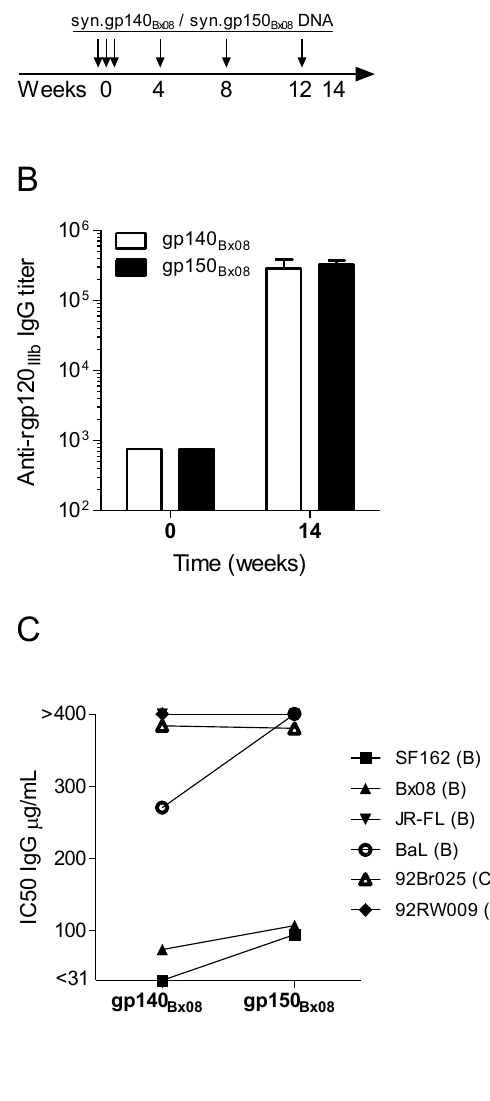
Figure 1. Immunization regimen and comparing antibody responses in syn.gp140 syn.gp150 . DNA vaccinated rabbits. ( A ) Schematic immunization schedule with Bx08